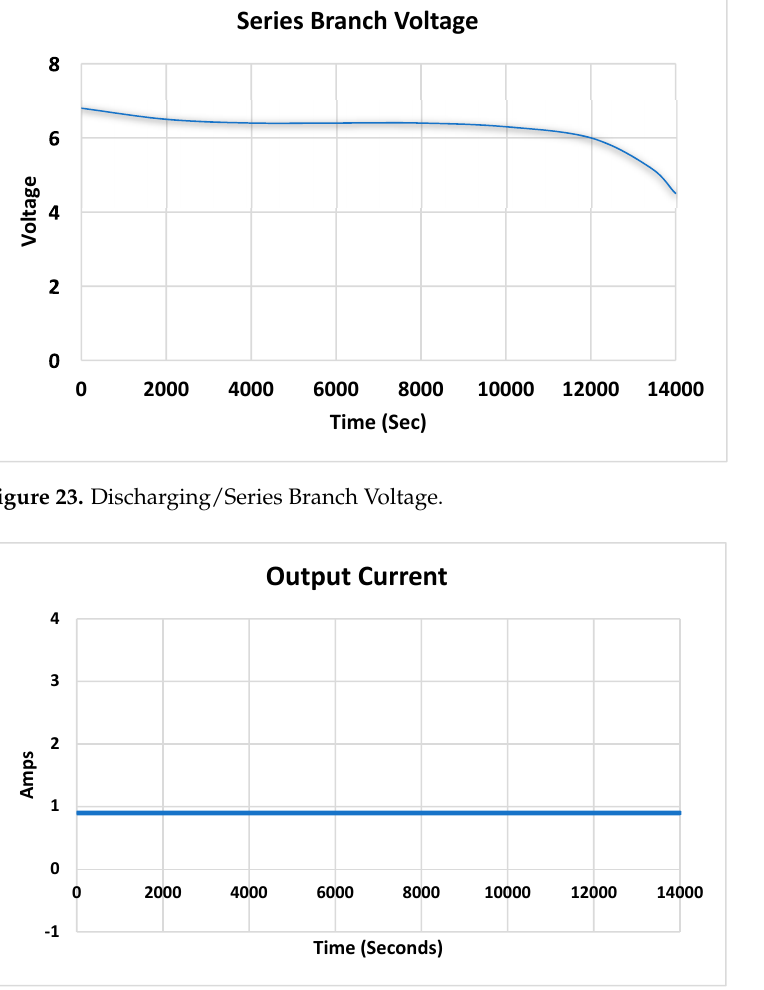
Figure 24. Discharging/Battery Current.